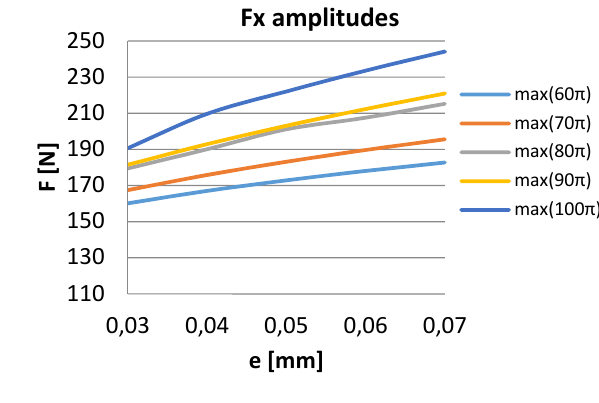
Fig. 9. Fx positive amplitudes